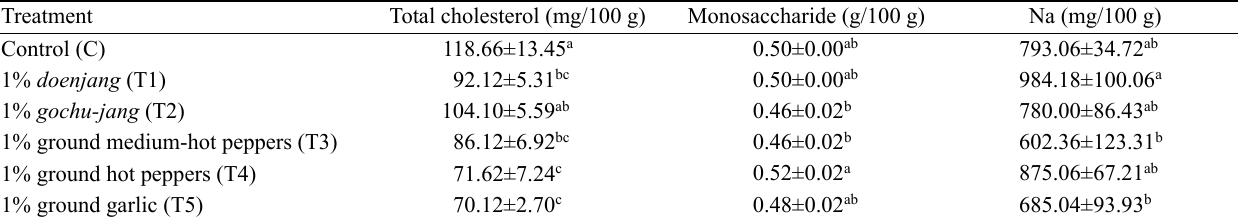
Table 5. Cholesterol, monosaccharide and sodium contents of fermented sausages as affected by the seasonings addition 1